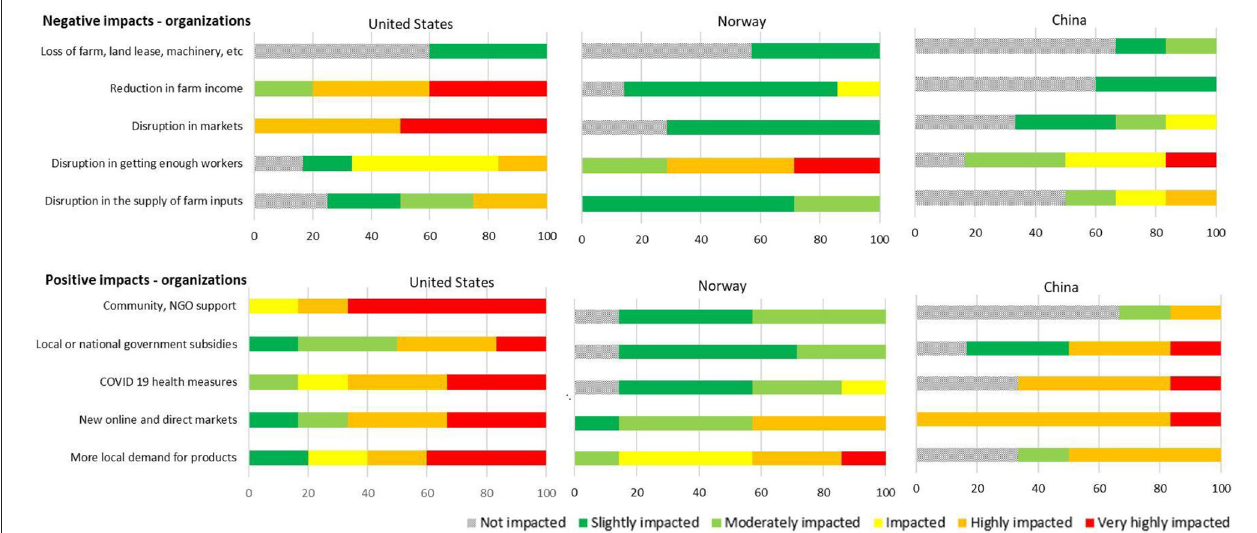
FIGURE 2 | Negative (top pains) and positive (bottom pains) impacts of the COVID-19 pandemic as perceived by interviewed support organizations on the farmers they serve or represent, shown as percentage distributions over the six different impact categories (gray = not impacted, green = slightly impacted, light green = moderately impacted, yellow = impacted, orange = highly impacted, red = very highly impacted), in the United States, Norway and China ( n =